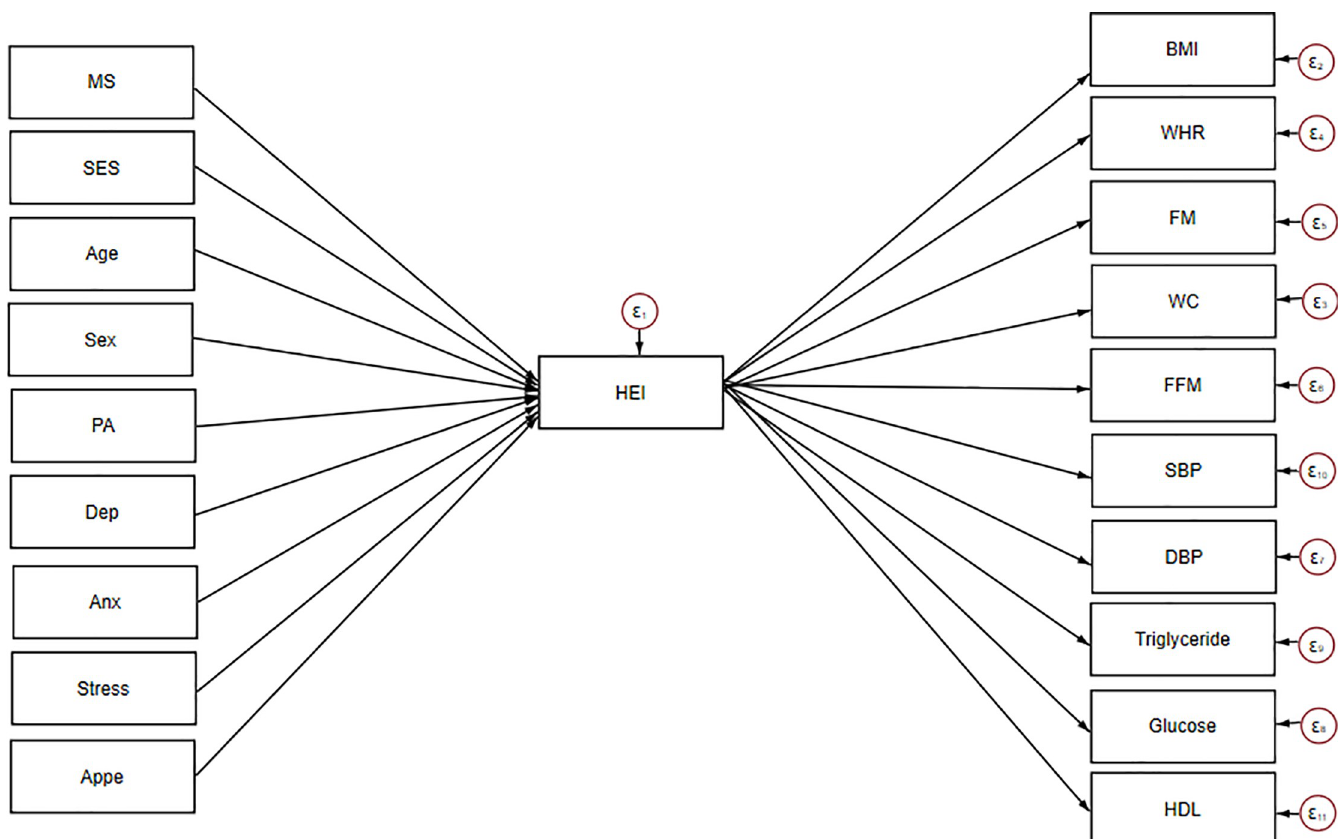
Fig 2. Hypothesized models in which HEI as a mediating variable relates socio-demographic variables and mental health to cardio-metabolic risk factors. Abbreviations: HEI, healthy eating index; WHR, waist–hip ratio; BMI, body mass index; WC, waist circumference; FM, fat mass; FFM, fat free mass; SES, socio- economic status; SBP, systolic blood pressure; DBP, diastolic blood pressure; HDL, high-density lipoprotein; PA, Physical activity; MS, marital status; Anx, anxiety; Dep, depression; Appe, appetite.